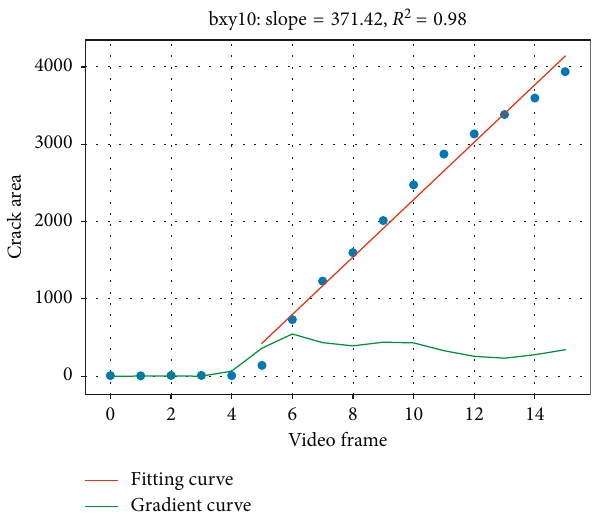
Figure 13: Crack quantitative results for